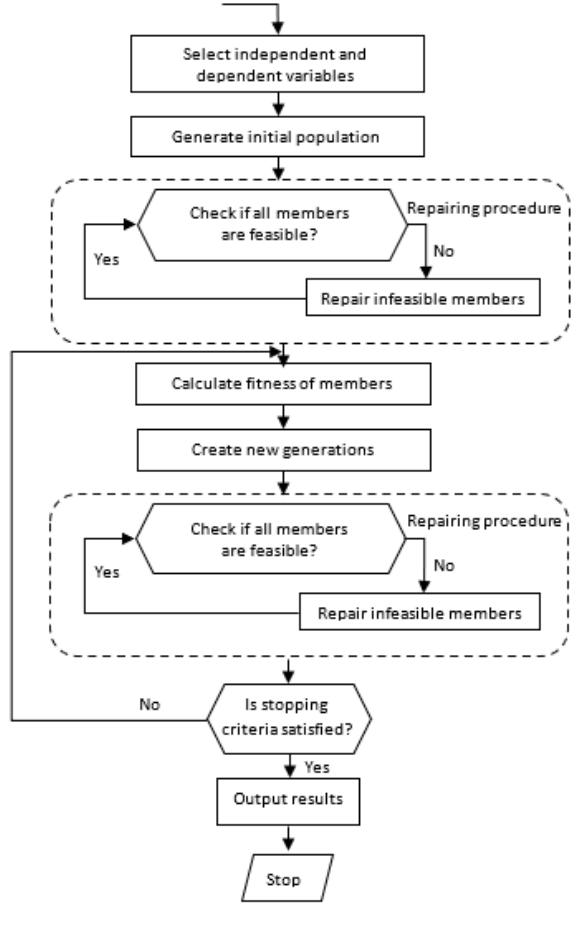
Figure 3. Progressive Genetic Algorithm (PGA) flow chart [27,28].